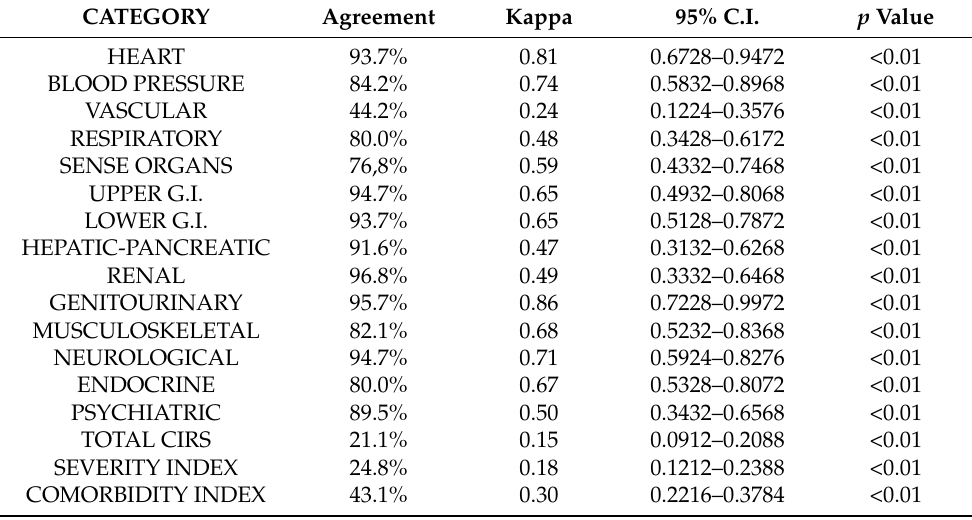
Table 1. Levels of agreement between the CIRS values reported by the pool of epidemiologists and ward doctors (first control). CATEGORY